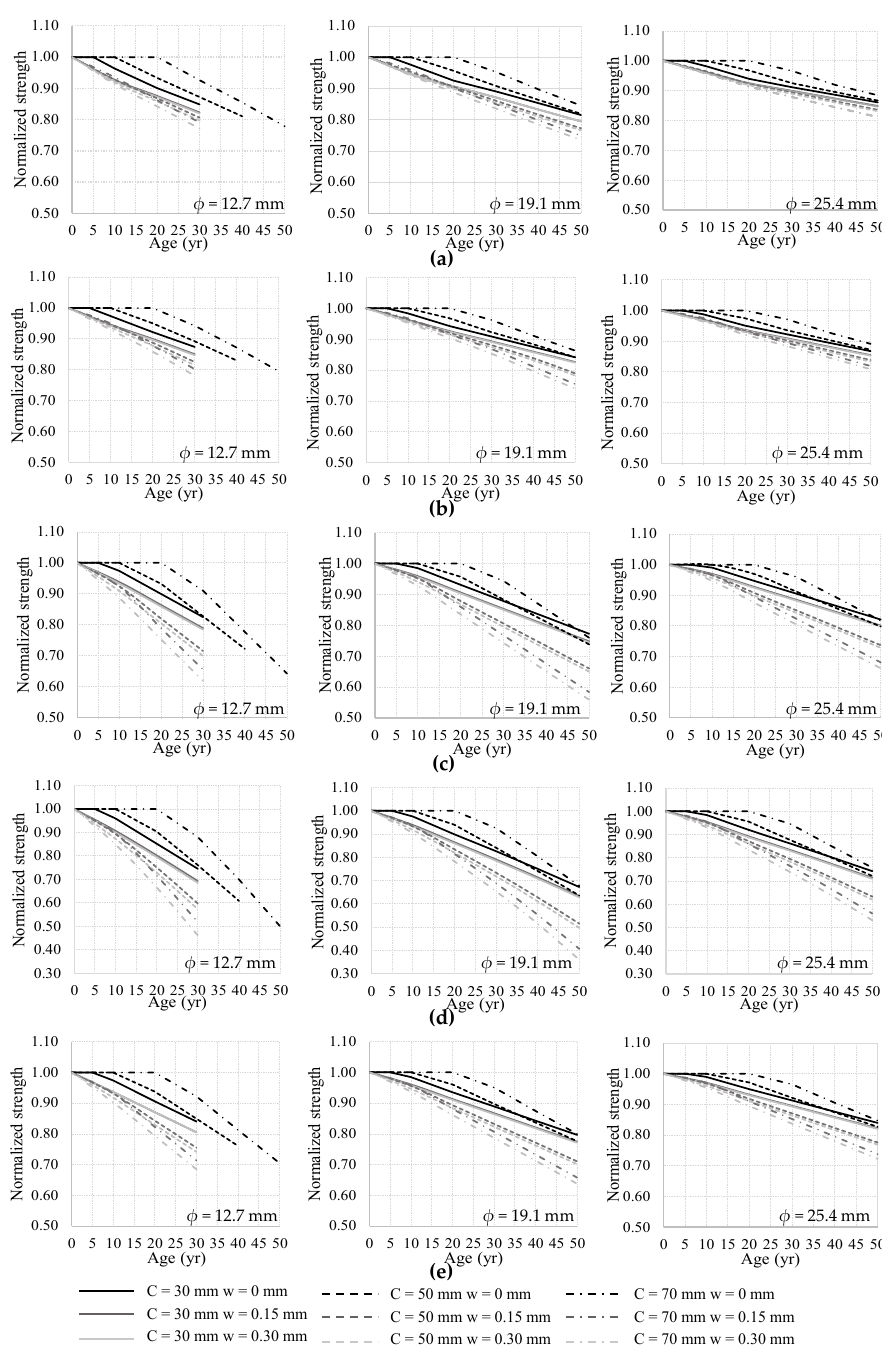
Figure 15. The normalized strength–structure age relation: ( a ) Bending strength; ( b ) flexo ‐ compressive strength in bending domain; ( c ) balanced flexo ‐ compressive strength; ( d ) flexo ‐ compressive strength in compression domain; ( e ) compressive strength.